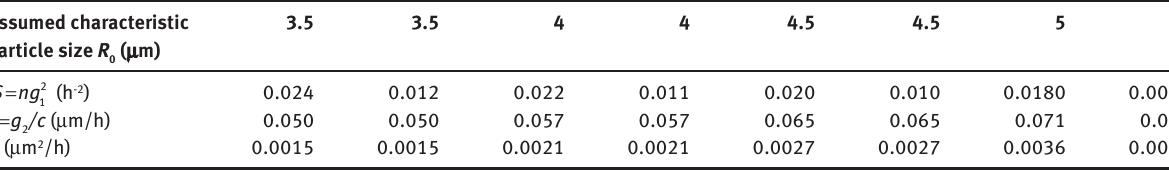
Table 2 Model parameters corresponding with different characteristic particle sizes. Assumed